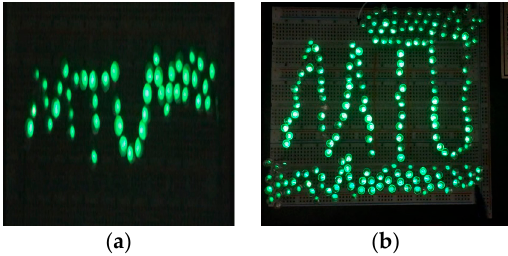
Figure 10. ( a ) A single WearETE powers 52 LEDs at each pulse. ( b ) A larger version of WearETE can